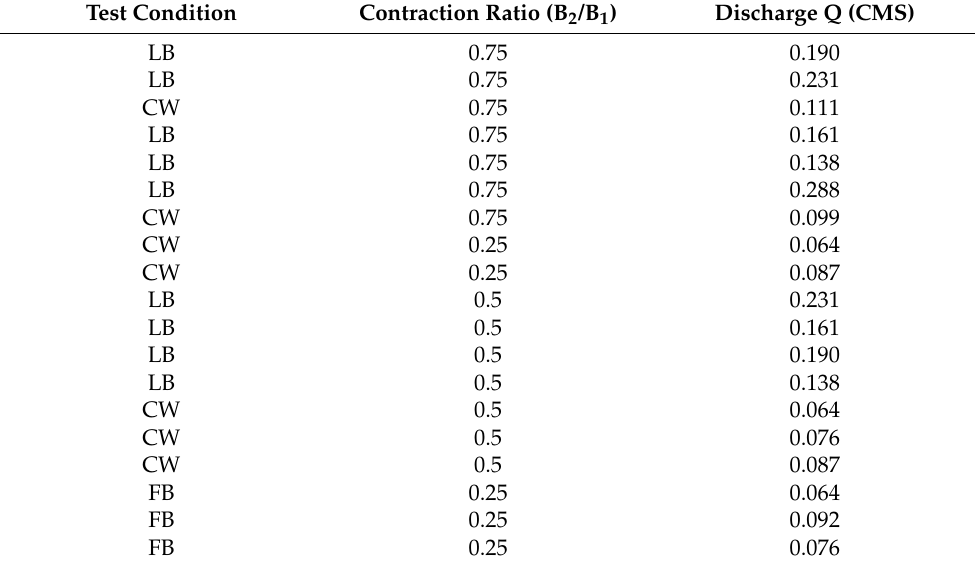
Table 2. Test conditions and their corresponding discharge (Q) and contraction ratio (B 2 /B 1